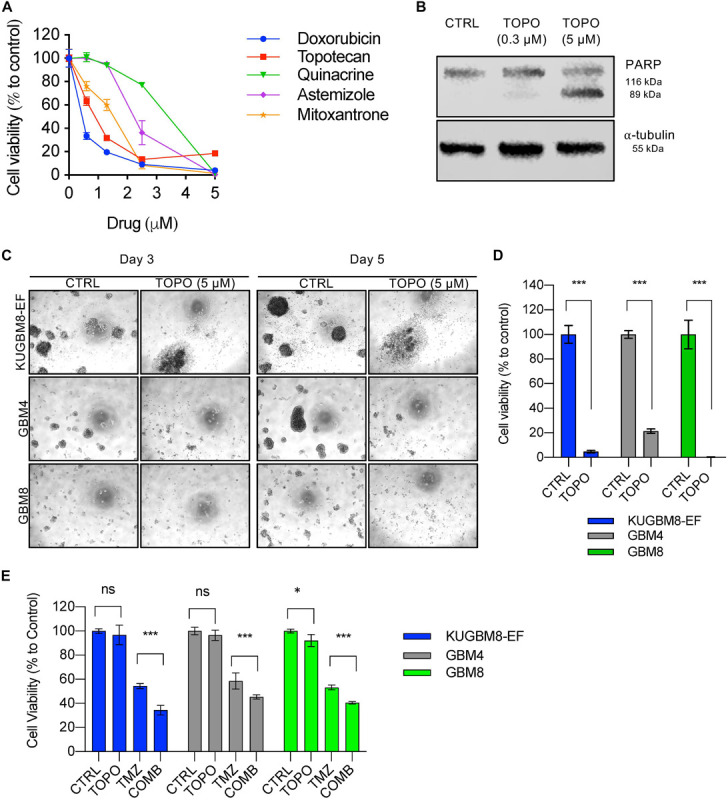
Hit validation revealed Topotecan as a potential apoptosis inducer in GBM (A) Dose response curves of selected hits treated for 3 days in 96-well format. (B) Detection of PARP cleavage after TOPO (0.3 or 5 μM) treatment for 24 h. α-tubulin was used as a loading control. (C) Representative photos of Topotecan (5 μM) response of 3 different primary GBM cell lines (KUGBM8-EF, GBM4, and GBM8) after 3 or 5 days of treatment. (D) Cell viability graphs of Topotecan (5 μM) treatment for 5 days on KUGBM8-EF, GBM4, and GBM8 cells. (E) The effect of low dose Topotecan (0.3 μM) combination with TMZ (250 μM for KUGBM8-EF, 65 μM for GBM4, and 10 μM for GBM8) on different primary GBM cell lines. Cell viability experiments were detected by CTG and viability was normalized to untreated controls. Error bars represent normalized standard deviation. n.s. stands for p > 0.05, ∗ stands for p < 0.05, ∗∗∗ stands for p < 0.0001, t-test.